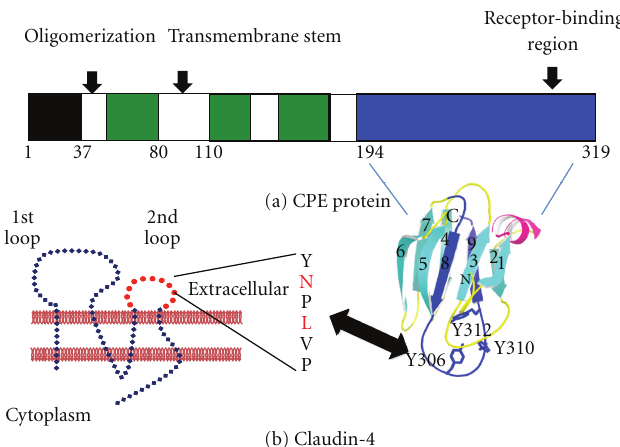
Figure 2: CPE structure versus function relationship. Panel A shows the functional regions of CPE, including the unstructured N-terminal sequences comprising amino acids 1–37 (black box), the domain II sequences mediating oligomerization and membrane insertion (white boxes), the domain III sequences that may participate when CPE inserts into membranes (green boxes), and the domain I sequences that mediate CPE receptor binding (blue box). Shown below the drawing is the structure of domain I (used with permission from [17]), including three tyrosine residues that interact with claudin receptors. Panel B shows the predicted structure of claudins. The amino acids in the turn region of extracellular loop 2 are shown to the right of claudin, with the two residues (N and, to a lesser extent, L) important for CPE binding highlighted in